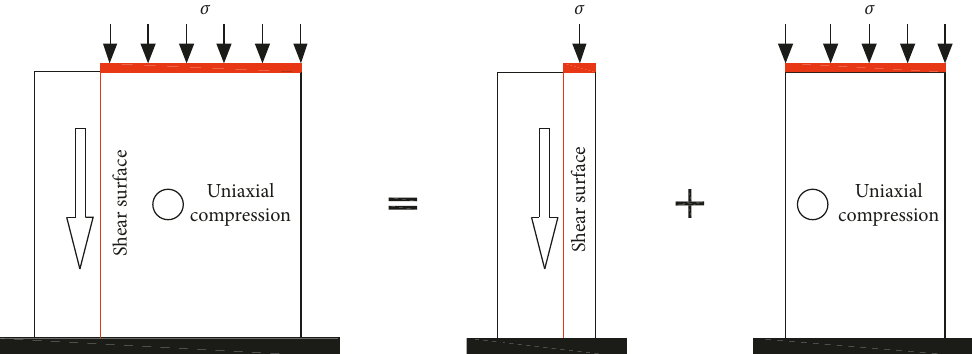
Figure 14: Mechanical model of local load.